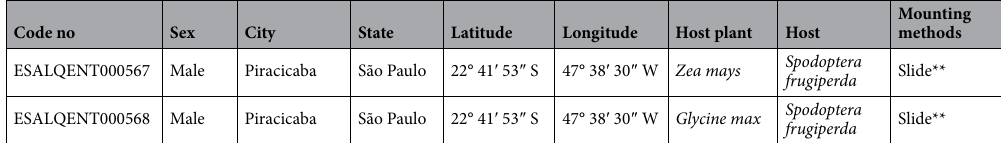
Table 1. Voucher specimens deposited in the Oscar Monte Entomophagous Insect Collection at the Instituto Biológico in Campinas, São Paulo, Brazil (IBCBE 003669, IBCBE and in the collection of the ESALQ Entomology Museum (MELQ). *Telenomus remus introduced from Venezuela by Embrapa Jaguariúna (source material Trinidad and Tobago). ** Telenomus remus used for molecular extraction and then mounted on microscope